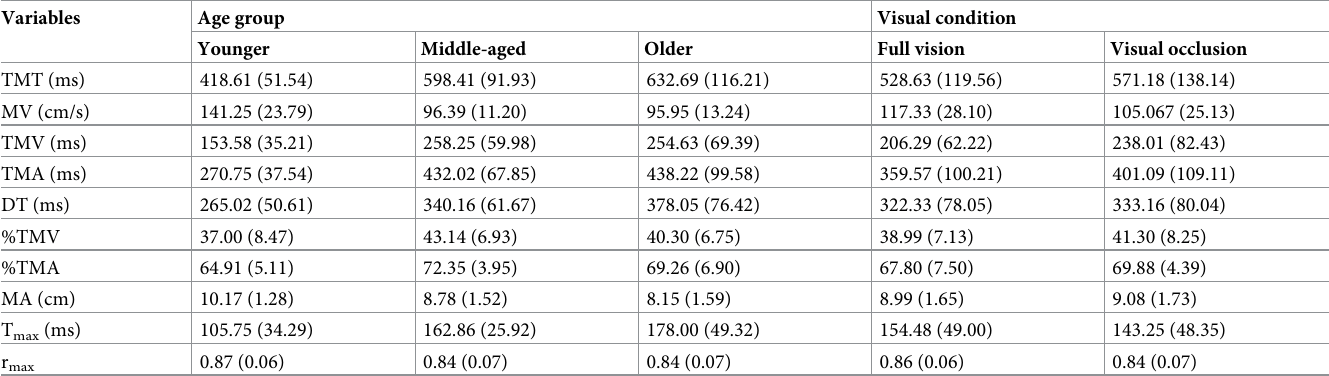
Table 2. Mean and standard deviations for all dependent variables.